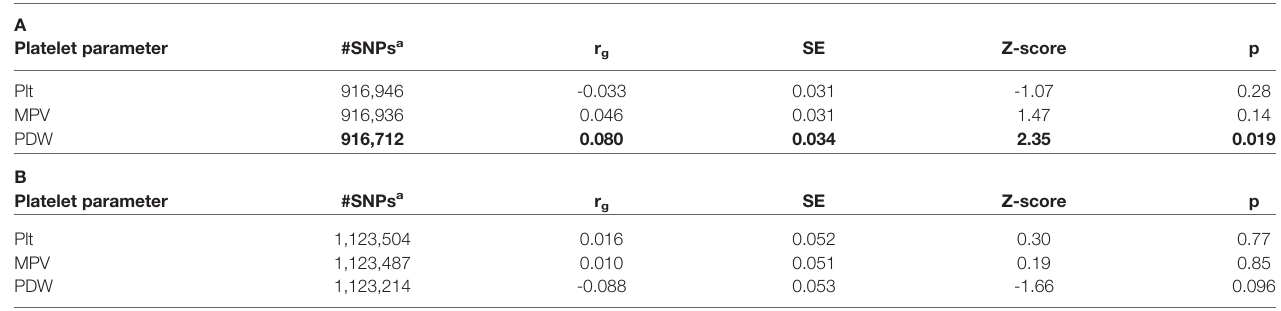
TABLE 1 | Genetic correlations of platelet parameters with (A) Parkinson ’ s disease and (B) Alzheimer ’ s disease risk, based on LD score regression analyses.